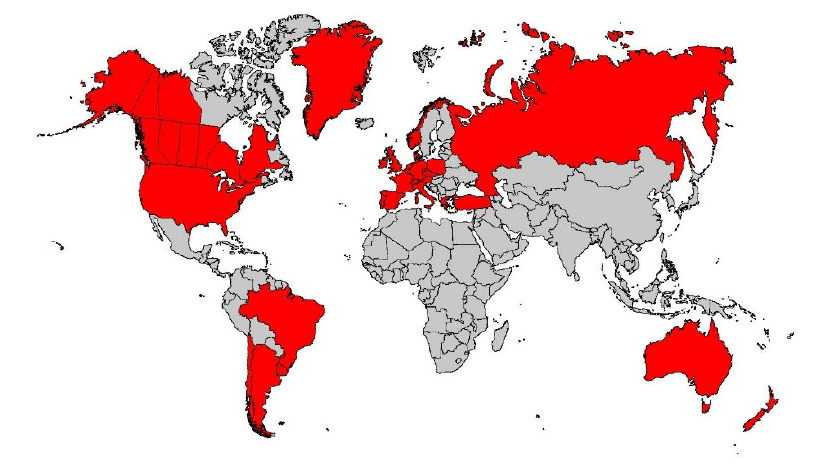
Figure 1. Cystic fibrosis newborn screening in 2020 around the world where the disease is prevalent.